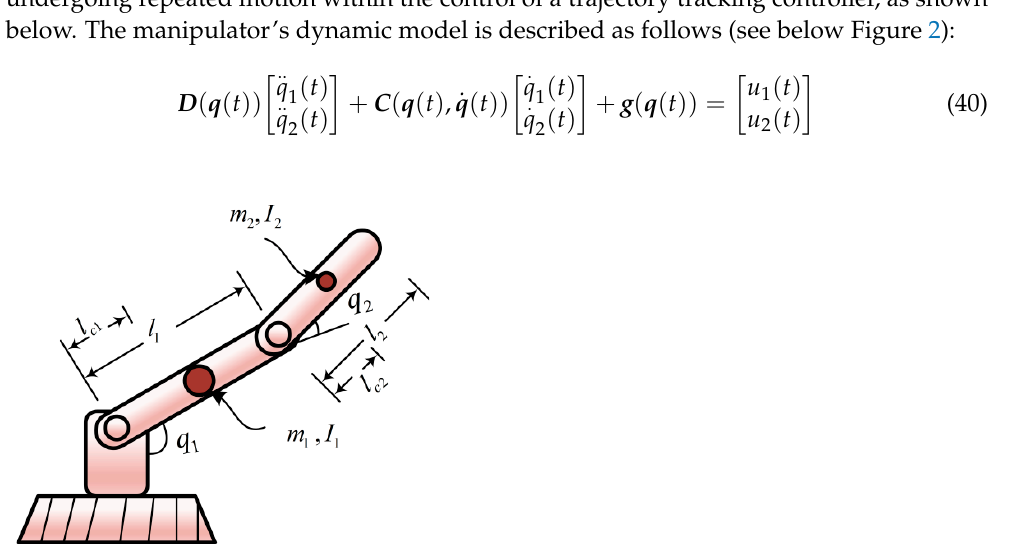
Figure 2. Two degree of freedom manipulator.